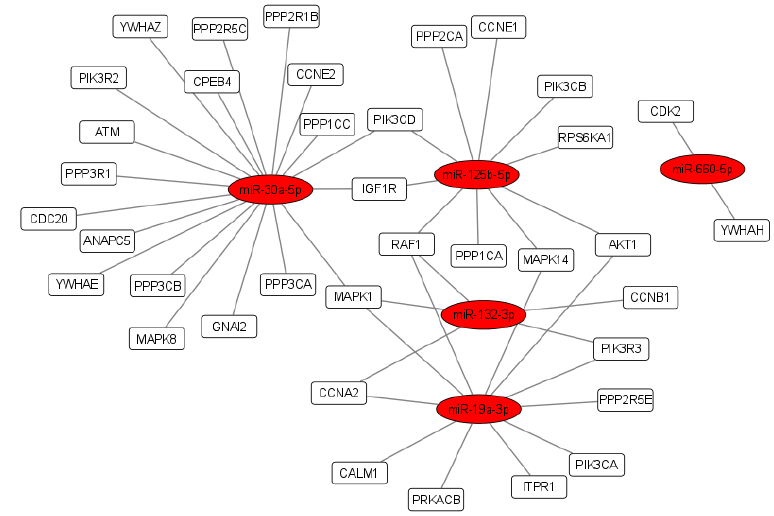
Figure 5. DE miRNA target genes related to oocyte meiosis. Regulatory network showing the interaction between miR-125b-5p, miR-132-3p, miR-19a-3p, miR-30a-5p, miR-660-5p and their validated mRNA targets. Red ellipses represent miRNAs and white rectangles represent mRNA target genes involved in oocyte meiosis.